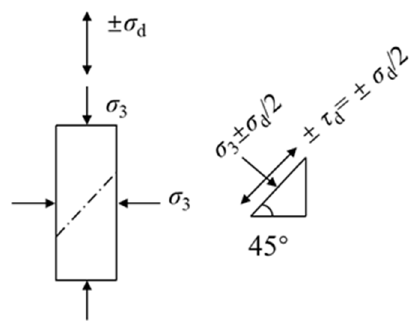
Figure 9. Stress state of unidirectional cyclic triaxial test.